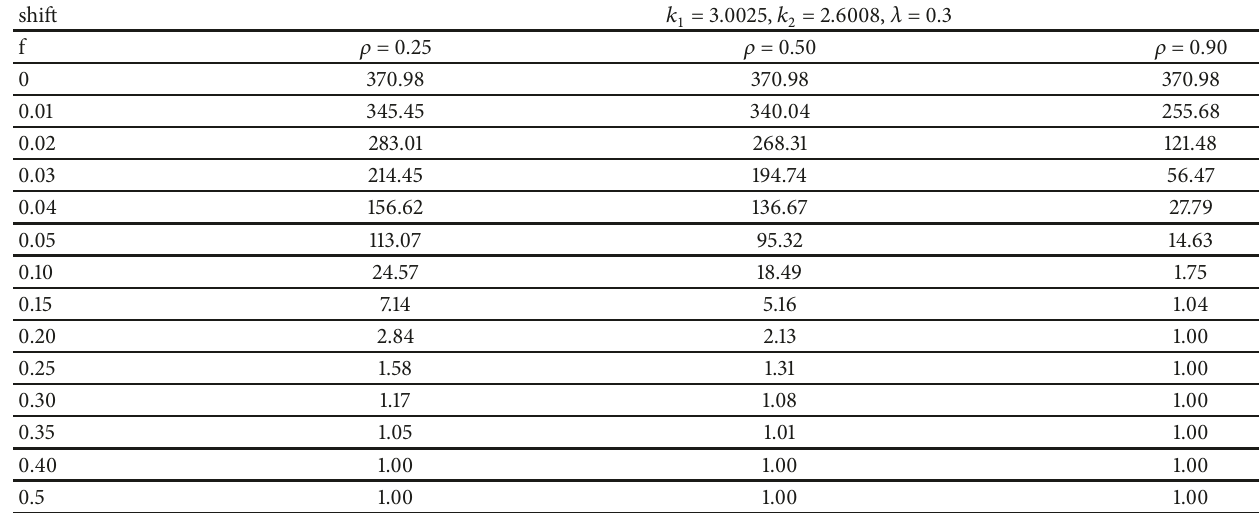
Table 12: ARLs for proposed repetitive EWMA-RSS control chart using Khan et al. [8] exponential ratio-type estimator, when 𝑟 𝑜 is 370. shift